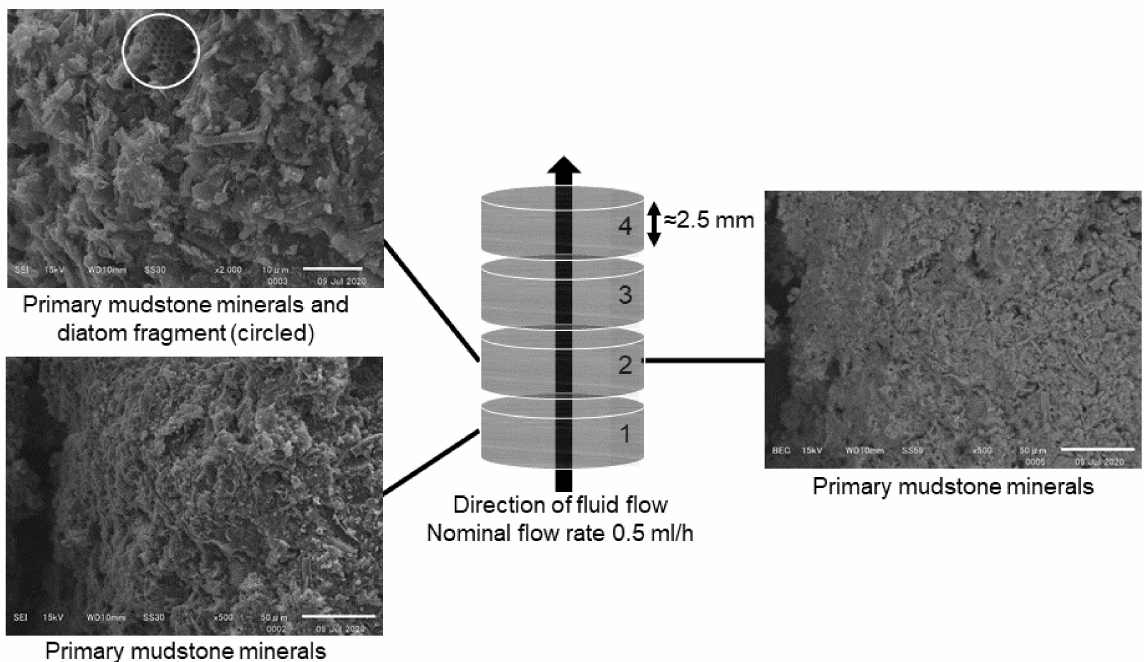
Figure 6. Summary of mineralogy, SFC experiment with the HFSC424 leachate. Arrow indicates direction of flow; numerals refer to Section numbers. Each section was ~2.5 mm long. All SEM photos are secondary electron (SE)